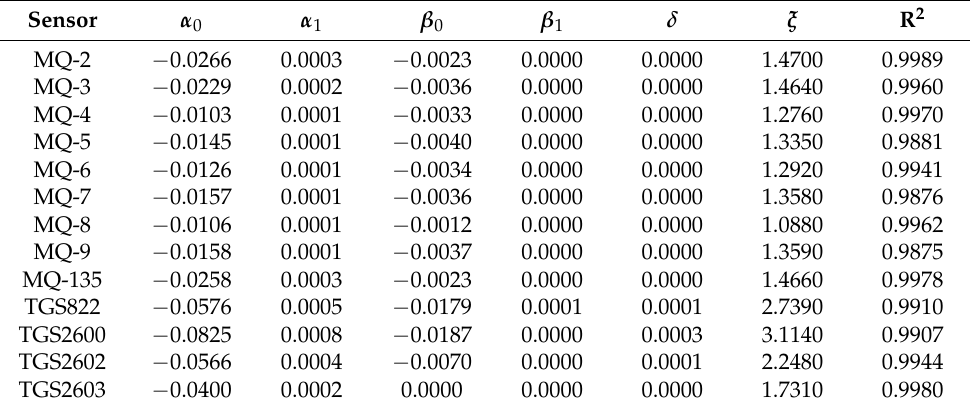
Table 3. Values of the constants used in the adjustment equations of the